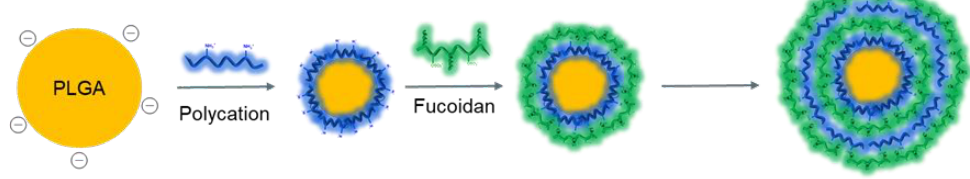
Figure 6. Scheme of the formation of core-shell polycomplexes by modifying the surface of NPs through successive deposition of counter-polyions.